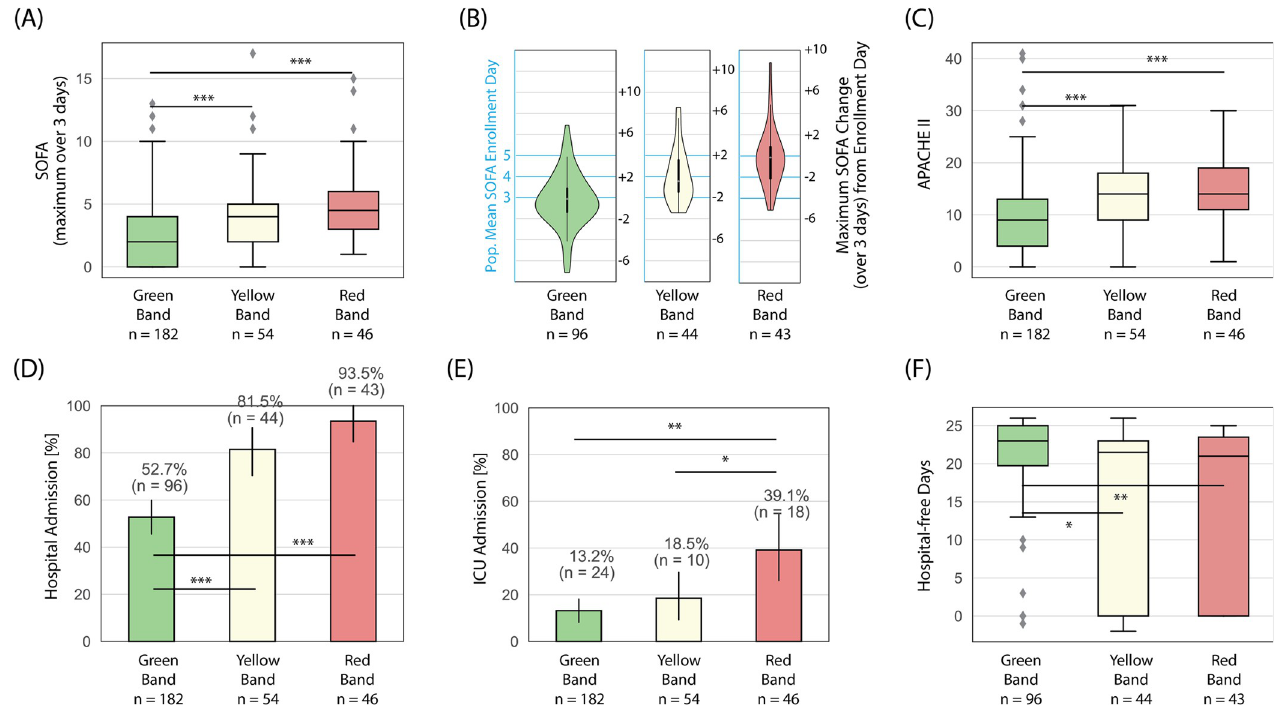
Fig 3. Trends in severity of illness scores and hospital utilization across ISI interpretation bands for all subjects. (A) SOFA scores, maximum calculated over up to 3-days with the subject’s baseline over the prior 6-months subtracted; (B) maximum SOFA change over 3-days from day of presentation; (C) APACHE II scores calculated using worse values over 24 hours following presentation; (D) hospital admission; (E) admission to the ICU; (F) hospital-free days in those admitted to the hospital, calculated as 28 –hospital length of stay, with zero for in-hospital mortality. Box plots: lines in the boxes, medians; the box ends, interquartile ranges (IQR); whiskers, 1.5x IQR; diamonds, outliers. Bar graphs: Bars, percentages; error pars, 95% confidence intervals. p-values were obtained from an unpaired two-sample Welch’s t-test (except for hospital free days, where the Mann–Whitney U was due to the non-normal distribution), with the null hypothesis that the mean of the two samples are equal. p-values reported as � p < 0.05, �� p < 0.01, and ��� p <